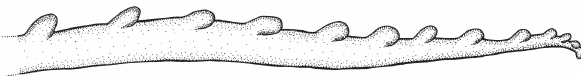
Fig. 5 . Maxillary barbel of Gelanoglanis pan , MZUSP 96032, paratype, 12.6 mm SL. Left side, anterior to left. Scale bar = 0.5